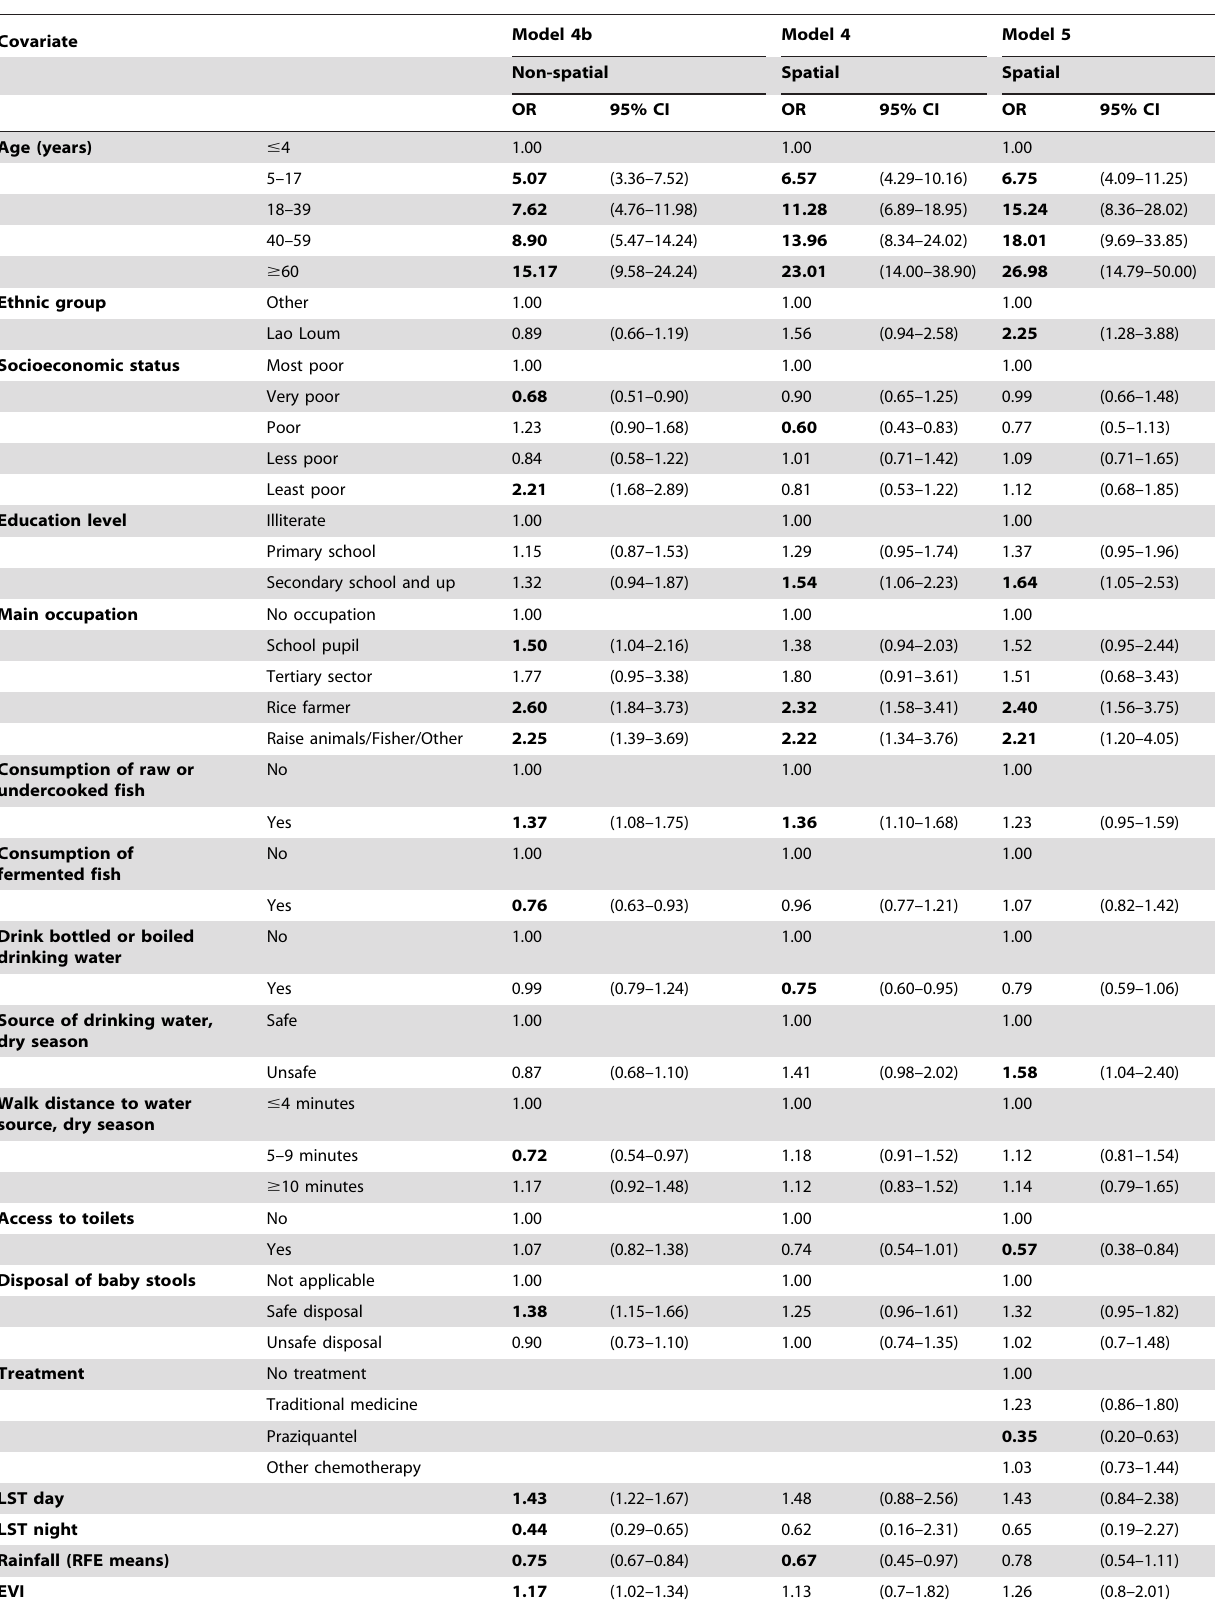
Table 3. Results for three multivariate models, including questionnaire-derived and environmental